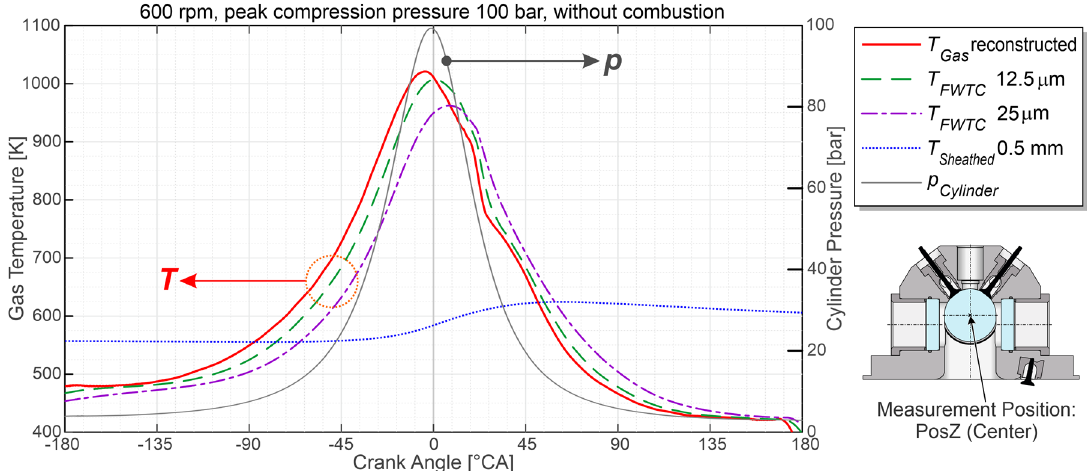
Figure 11. Traces of the measured temperatures (thermocouples Ø12.5 µ m and Ø25 µ m) and the reconstructed actual gas temperature. For comparison, the temperature that is measured with a common Ø0.5 mm sheathed thermocouple is shown as well (blue dotted line).